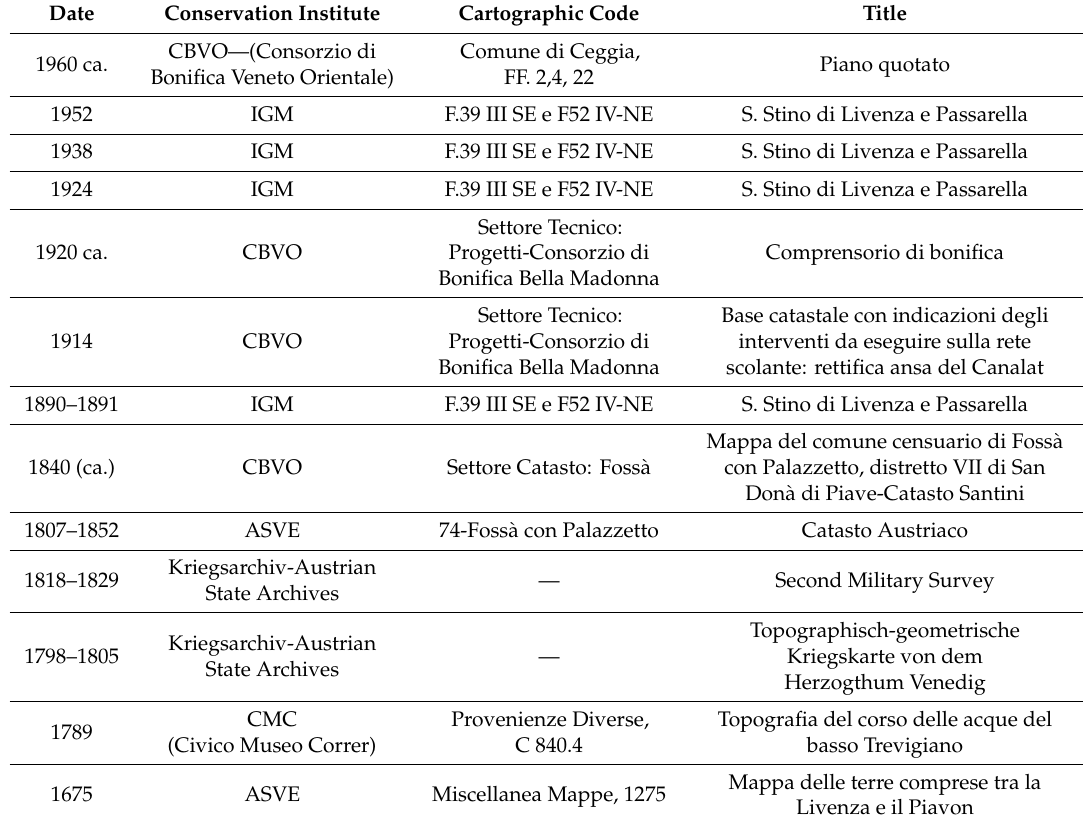
Table 2. List of historical cartography analyzed for the